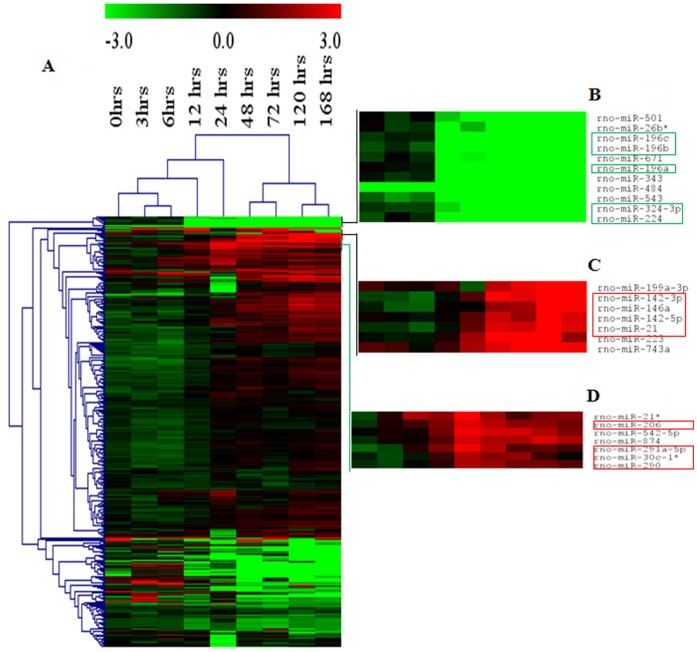
Heat map of the miRNAs that are regulated at different times following MCAo.The signal log ratio values (vs normal rats) were used to construct the hierarchical clustering using the Euclidean distance and average linkage method, carried out on both the samples column and the miRNAs rows. Only significantly different (ANOVA single factor, p value <0.05) miRNAs were included for analysis. Green: downregulation; Red: upregulation. (A) The expression of 334 miRNAs that are statistically significant are represented in the heat map; (B) Cluster of miRNAs that show a decrease in expression during the progression of cerebral ischemia (rno-miR-196a, -196b, -196c, -224, -324-3p); (C) Cluster of miRNAs that show an increase in expression during the progression of cerebral ischemia (rno-miR-21, -142-3p/5p, -146a); (D) Cluster of miRNAs that show an expression which positively correlated with infarct volume during the progression of cerebral ischemia (rno-miR-206, -290, -291a-5p and -30c-1*).